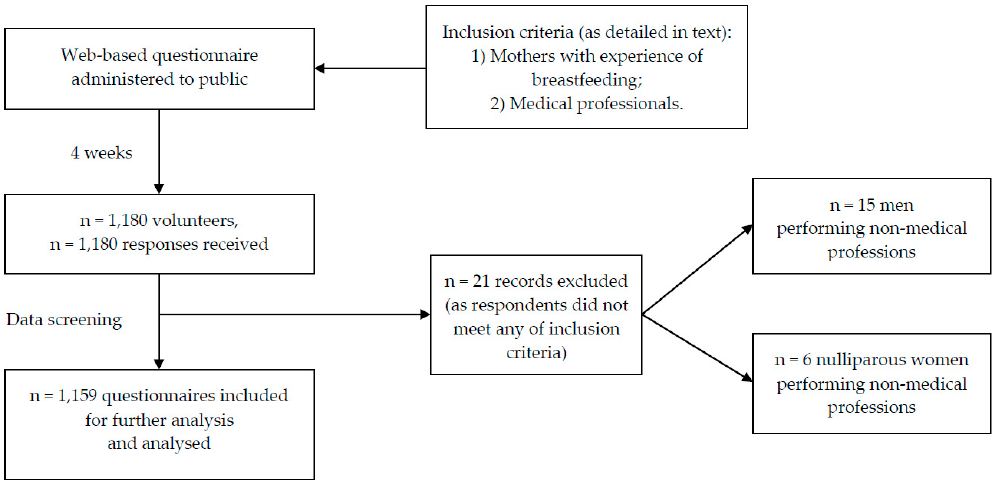
Figure 1. Flowchart on study group recruitment steps .